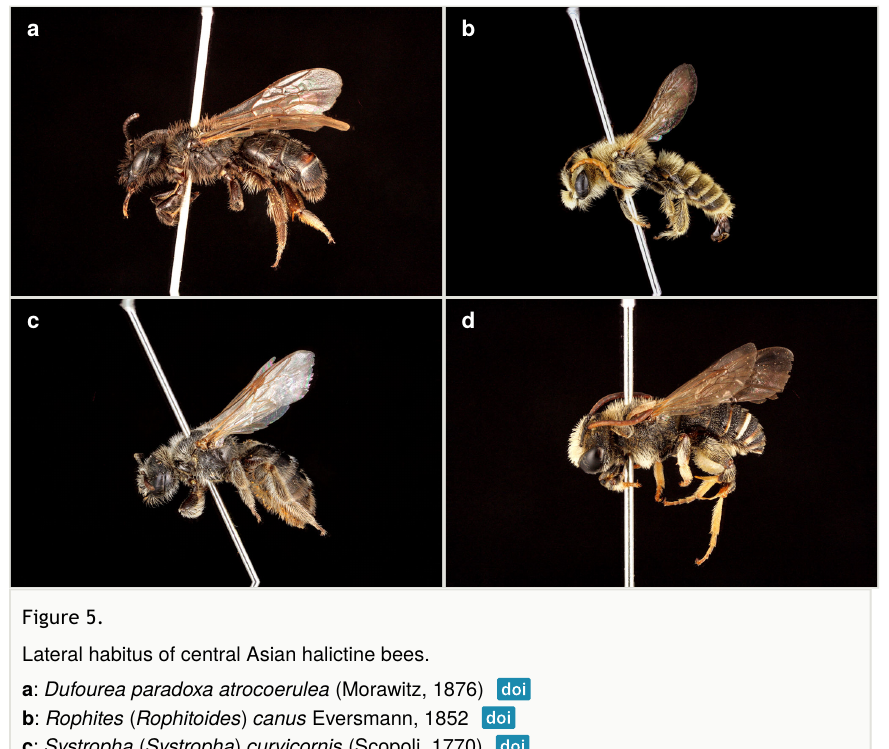
Figure 5. Lateral habitus of central Asian halictine